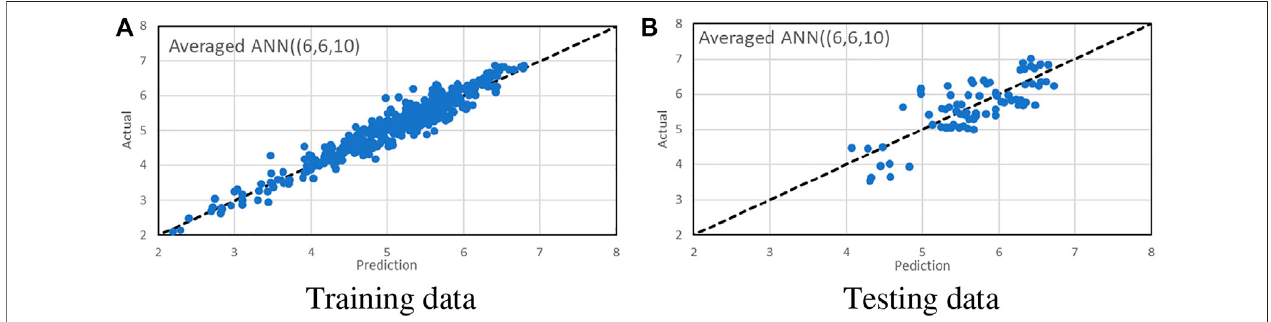
FIGURE 10 | Actual vs. prediction of ANN ( fi rst layer: six inputs, six neurons; second layer: 10